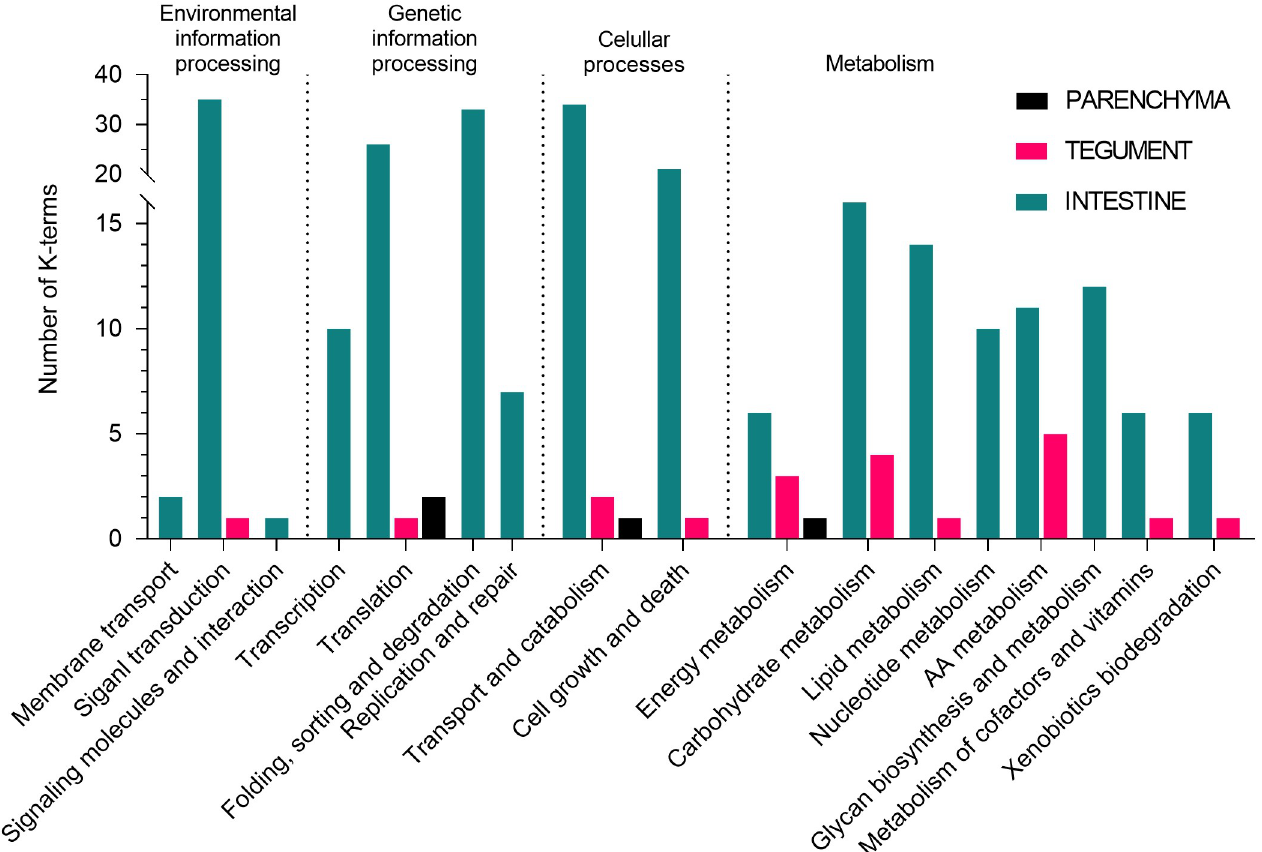
Fig 3. KEGG pathway annotation of the unique proteins from each tissue. Only proteins identified by � 2 peptides in both replicates of a given sample and by � 1 peptide in other samples are considered unique to a sample.